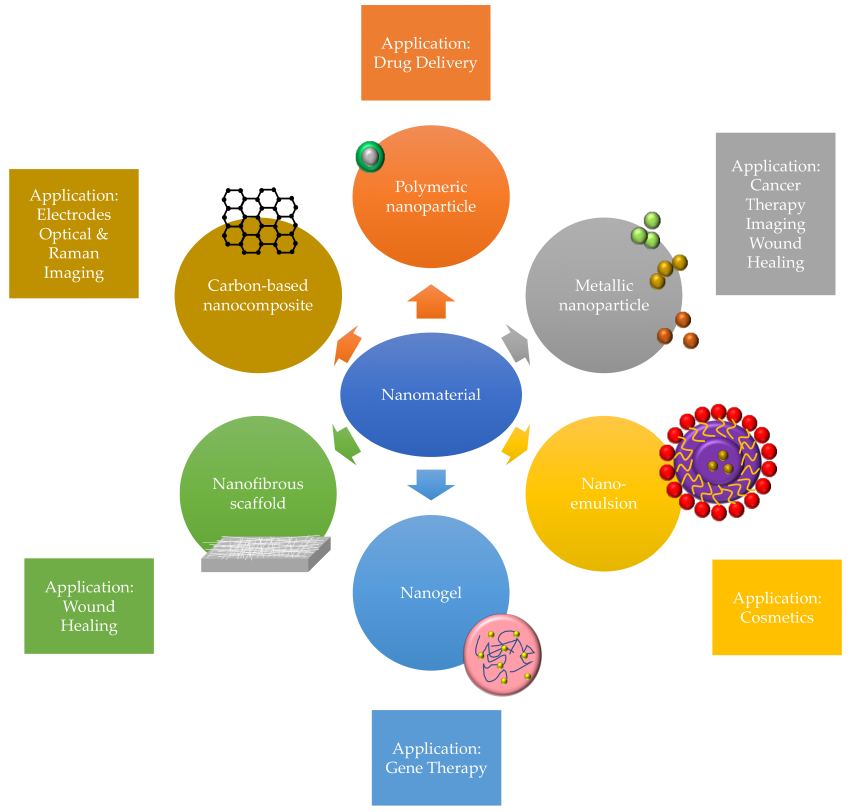
Figure 2. The types and application of